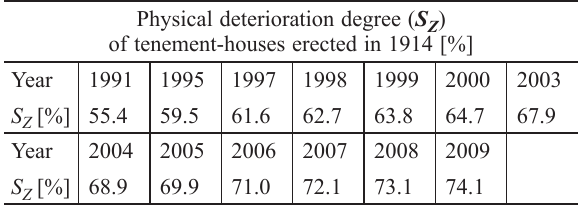
Table 2. Physical deterioration degree calculated according to formula (5) for a whole tenement-house Physical deterioration degree ( S Z ) of tenement-houses erected in 1914